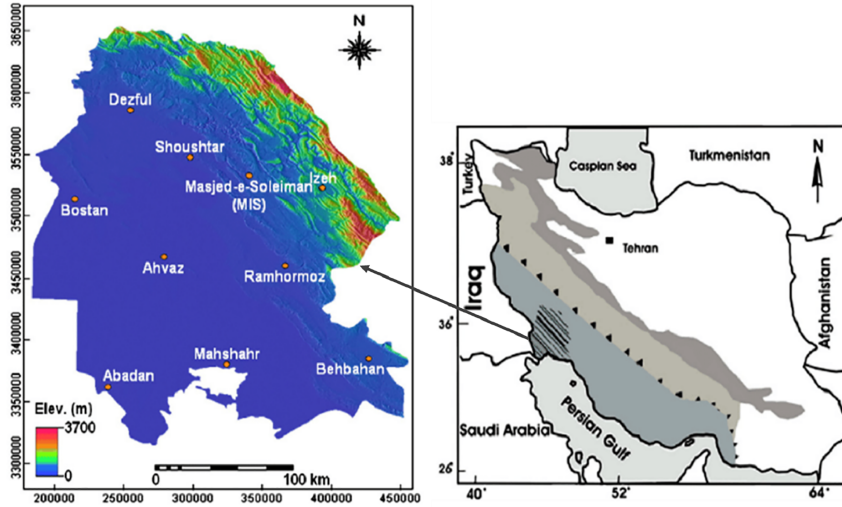
Figure 1. Location of the study area in